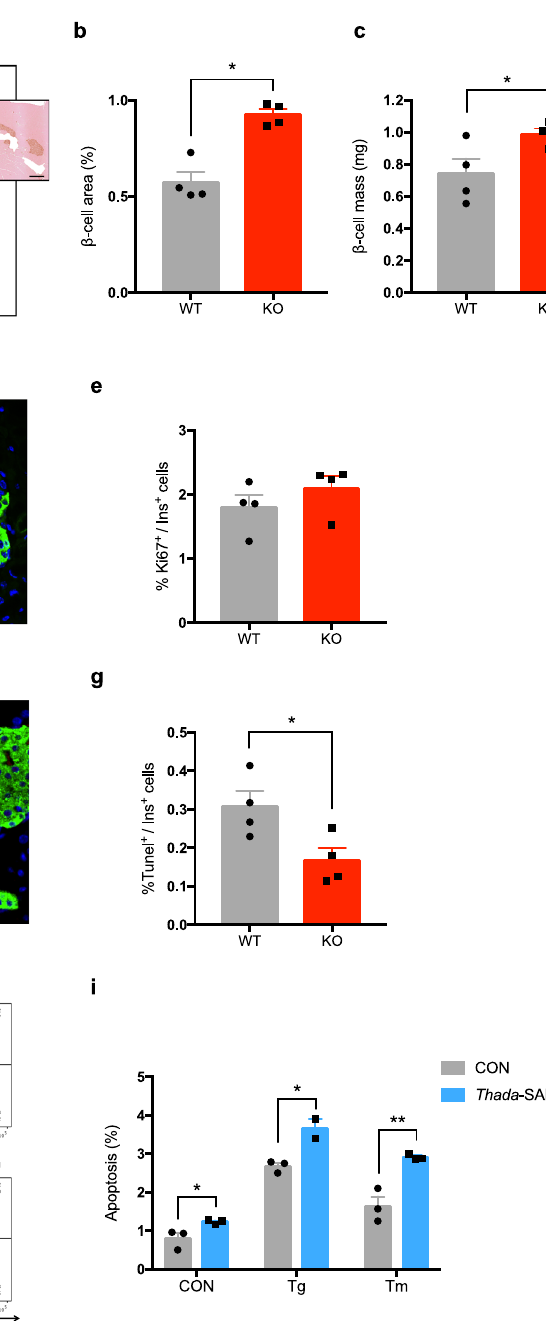
20 μ m. Arrowhead points to Tunel + Insulin + cells. g The apoptosis of β -cell was determined by quanti fi cation the percentage of Tunel + in Insulin + cells ( n =4 mice each group). 4204±871 Insulin + cells were quanti fi ed for WT mice and 4568±591 Insulin + cellswerequanti fi edforKOmice. h Flowcytometryanalysisofcontroland Thada -SAM MIN6 beta-cell lines treated with or without 1 μ M thapsigargin (Tg) or 1 μ g/ml tunicamycin (Tm) for 24h. Representative dot plots of cell apoptosis were shown after dual staining with Annexin V and 7-AAD. The gating strategy was providedinFig.S4l. i Theapoptosisofcontroland Thada -SAMMIN6beta-celllines were quanti fi ed by the percentage of Annexin V-positive cells ( n =4). The animal experiments were performed on male mice at 8-10 weeks of age and female mice data were provided in Figure S4. Data are presented as mean±SEM. * P <0.05, ** P <0.01; signi fi cance is assessed by two-tailed unpaired Student ’ s t test. Source data are provided as a Source Data fi